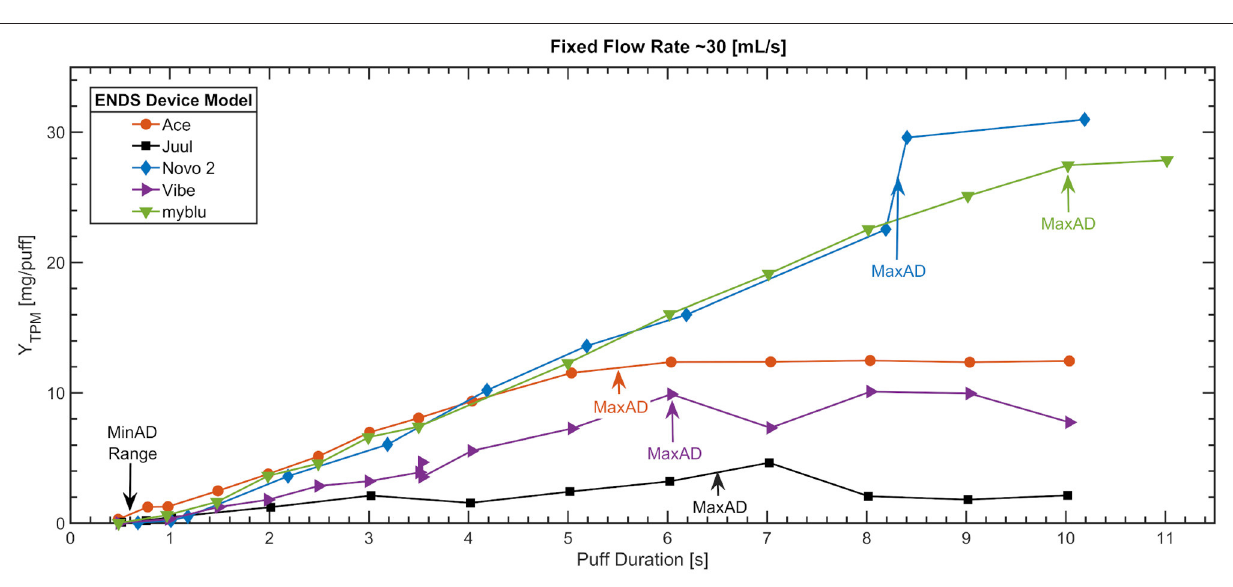
in emissions yield from Vibe relative to the other ENDS.